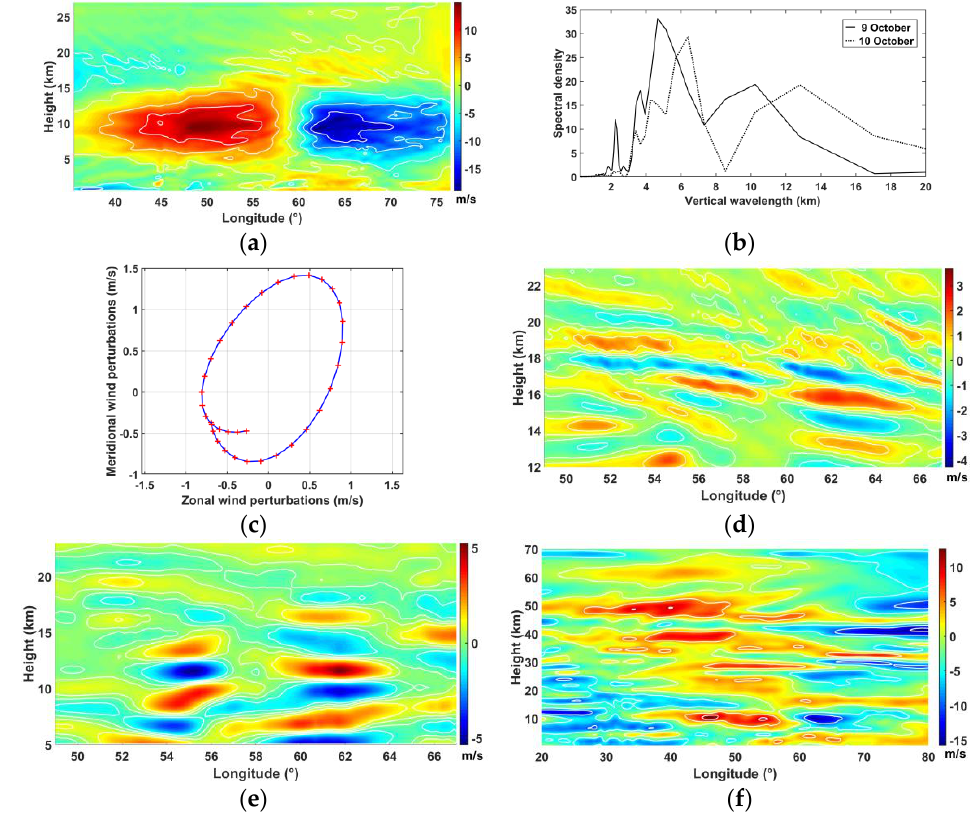
Figure 17. ( a ) Same as Figure 16c but for MRA components d 3 + d 4 + d 7 + a 7 ; ( b ) fourier spectral densities of meridional wind perturbations on 9 and 10 October at 1200 UTC at heights of 5–27 km at longitudes between 52 ◦ E and 54 ◦ E; ( c ) hodograph of filtered simulated horizontal wind perturbations on 9 October at 1200 UTC (17–20.5 km) above Reunion (21 ◦ S, 55 ◦ E); height–longitude distributions of meridional perturbations at 21 ◦ S ( d ) 0.8–3.2 km (d 3 + d 4 ) and ( e ) 3.2–6.4 km (d 5 ). ( f ) Same as ( e ) but with vertical wavelengths of 4–16 km superposed on the background wind using ERA5 data.